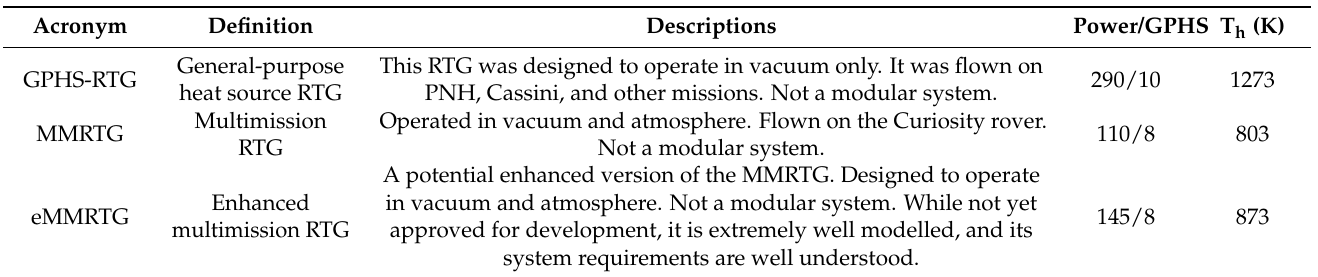
Table 1. Types of RTG technologies by NASA. Reproduced with permission from “NASA Special Ses- sion: Next-Generation Radioisotope Thermoelectric Generator (RTG) Discussion” from the National Aeronautics and Space Administration, 2017